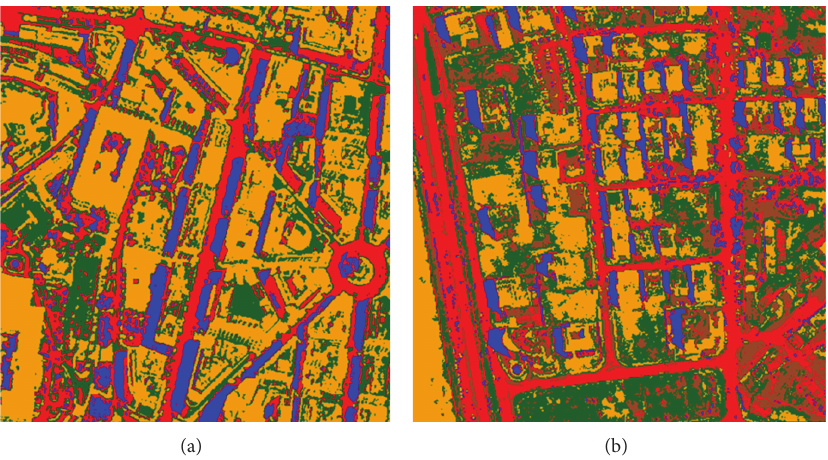
Figure 3: Classified images using SOMs-FCM: (a) first experiment, (b) second experiment.